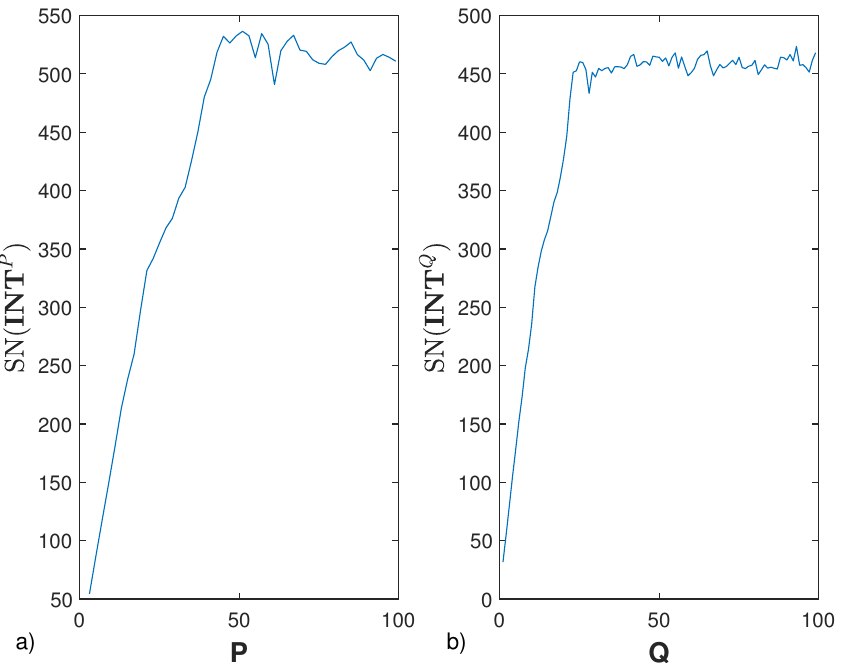
Figure 5. The Shannon Number of INT P (panel ( a )) and INT Q (panel ( b )) in terms of P and Q . The parameters are the same of Figure 3.